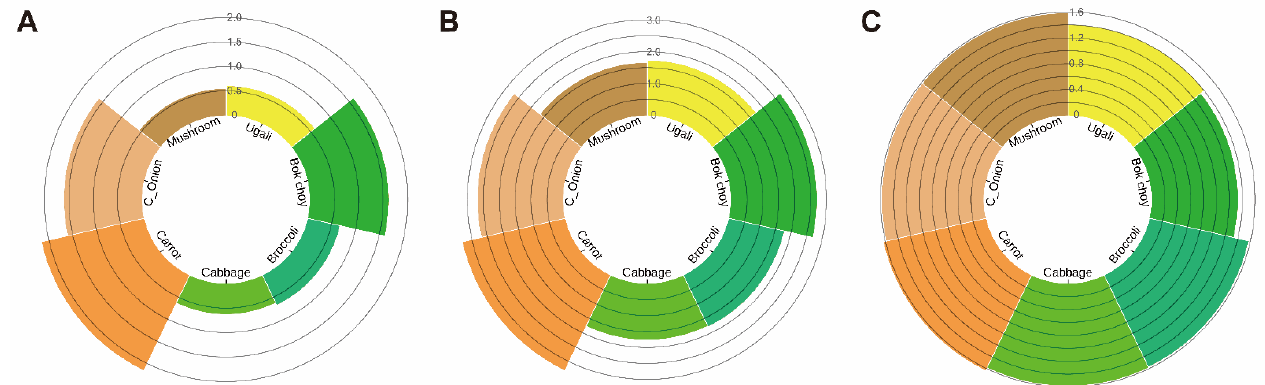
Figure 2. Nutrition value of 100 g different vegetable fortified ugali . ( A ) is the vitamin A content in 100 g vegetable fortified ugali ( μ g RAE/100 g) and ( B ) is the carotenoids content in 100 g vegetable fortified ugali ( μ g/100 g). The y -axis of ( A , B ) is in the log 10 range. ( C ) is the dietary fiber content in 100 g vegetable fortified ugali (g/100 g). The nutrition value was calculated as 20g of each vegetable fortified into 100 g corn flour ugali , and this figure shows the nutrition content of 100 g final fortified ugali . The original nutrition value of each vegetable was obtained from the U.S. Department of Agriculture, Food Data Central.